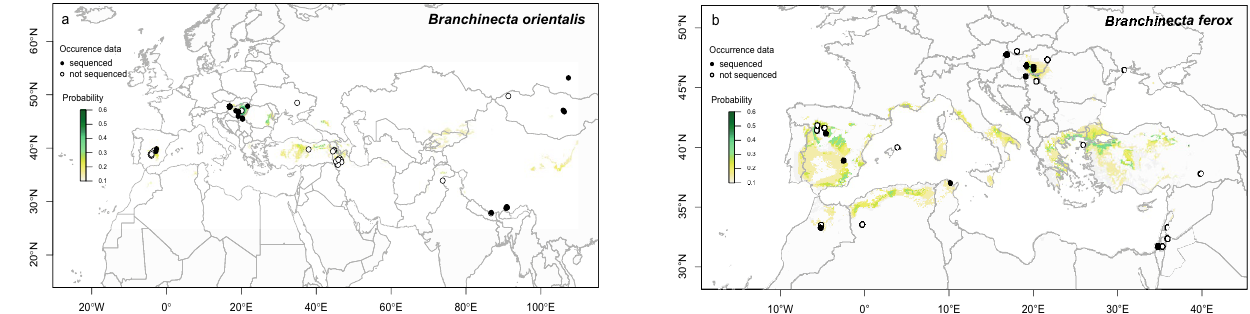
Figure 1. ( a ) The currently known distribution of the two study species, Branchinecta ferox ( a ) and Branchinecta orientalis ( b ), based on published distribution data in the last 50 years (circles), the populations included in the molecular analyses (filled circles), and their predicted distribution area (yellow to green shading) according to bioclimatic data. Maps were created with the ‘dismo’ package 101 of R v. 4.0.3 102 .